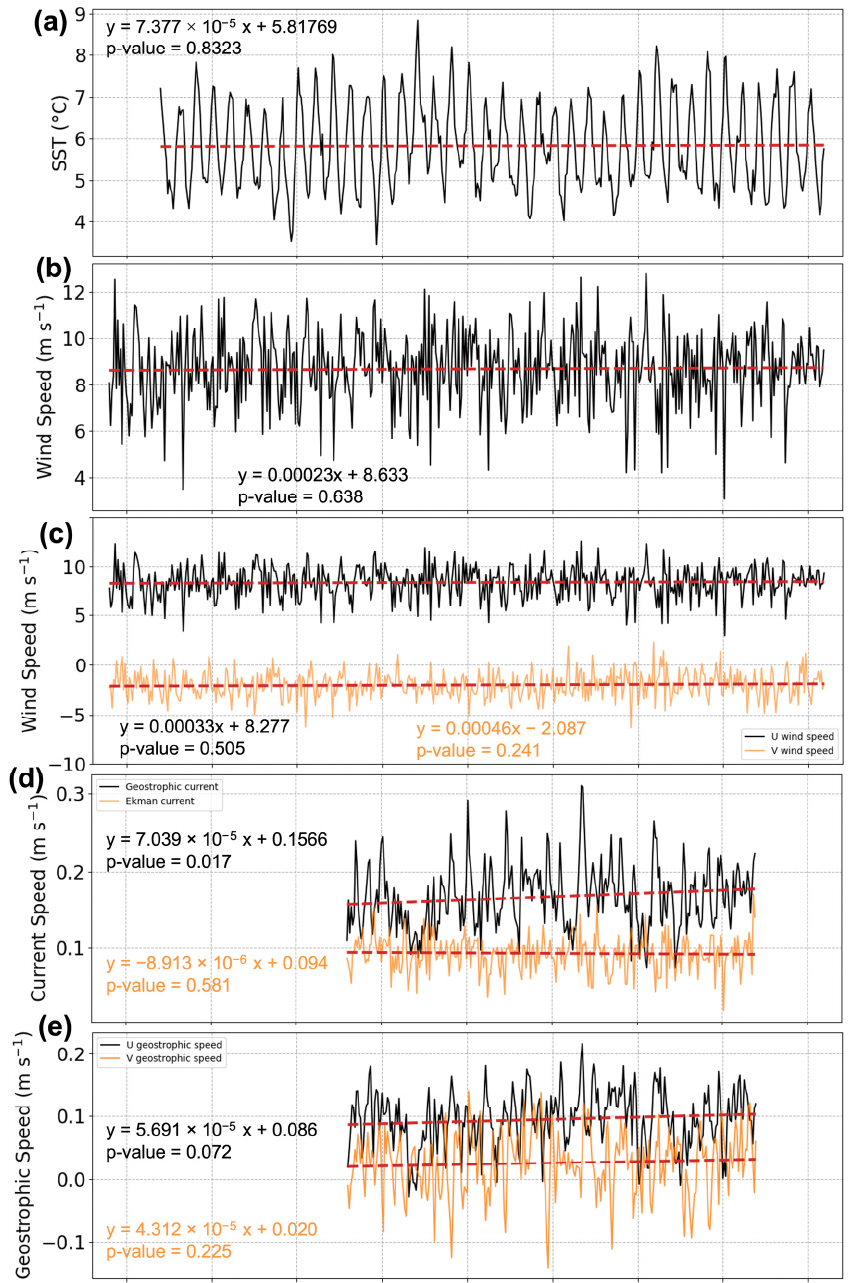
Figure 4. Time series of the monthly mean ( a ) Sea Surface Temperature (SST), ( b ) Wind speed ( c ) Zonal (in black) and meridional (in orange) wind speed components, ( d ) Geostrophic (in black) and Ekman (in orange) current speeds, and ( e ) Zonal (in black) and meridional (in orange) geostrophic current speed components. The red dashed lines represent the linear trends of each time